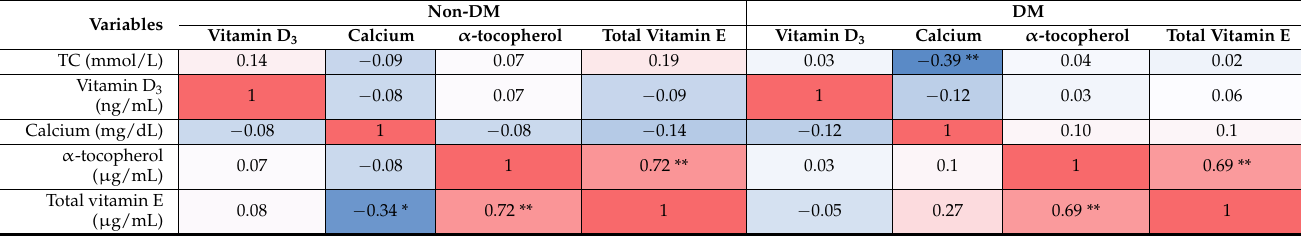
Table 11. Heat maps of the bivariate analysis for the correlation study determined using Spearman’s correlation